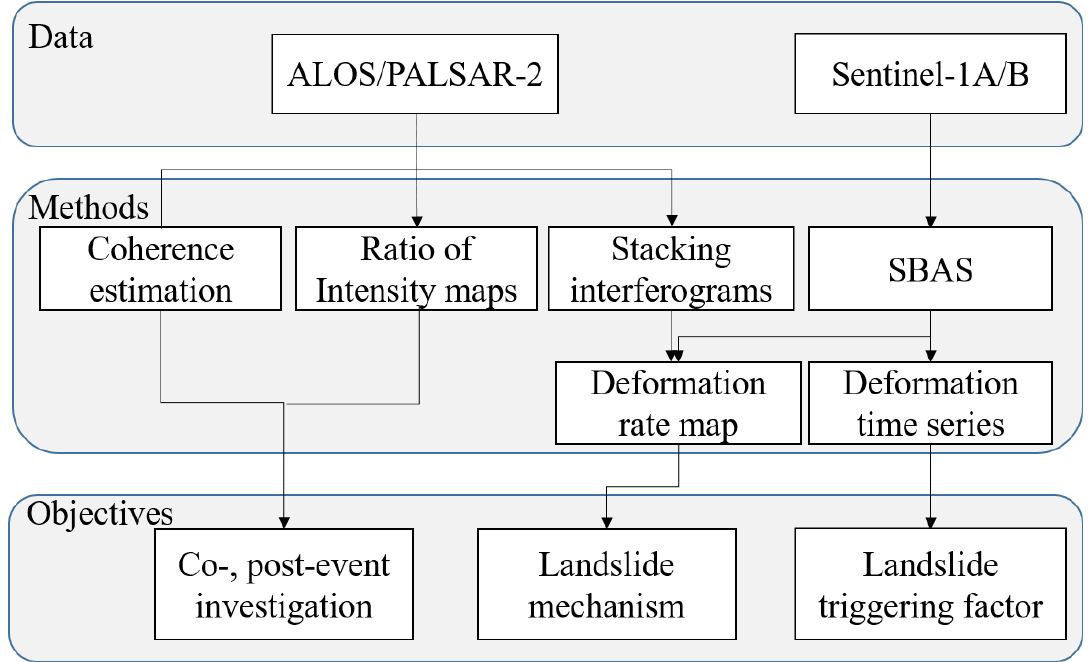
Figure 5. The flowchart for Pusa landslide analysis.